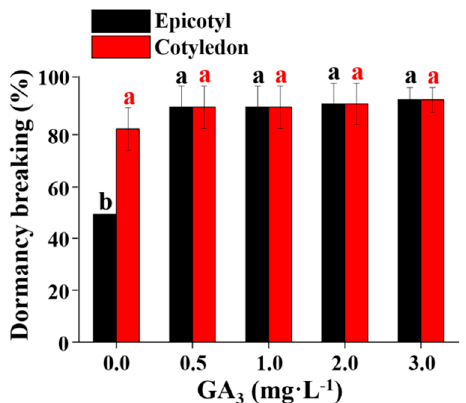
Figure 3. The percentage of epicotyl dormancy breaking affected by the GA 3 concentration. Different letters indicate separation among treatments by Duncan’s multiple range test at a 5% level.